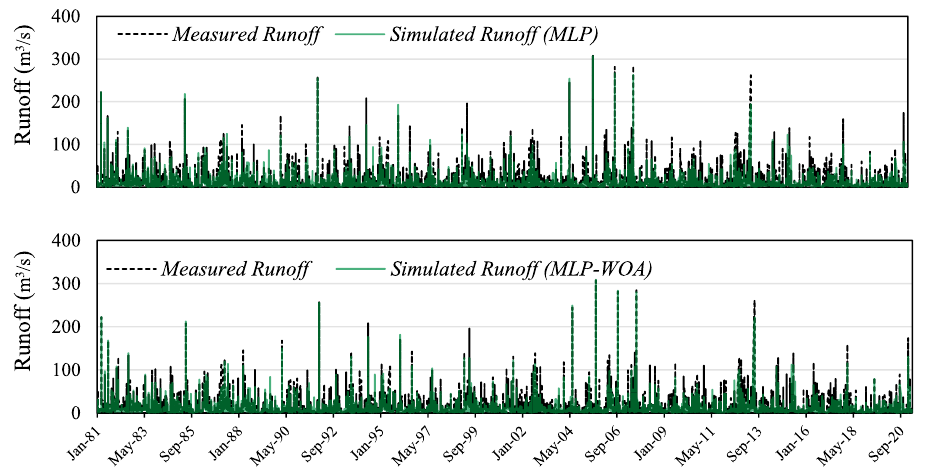
Figure 10. Time series plot related to the result of MLP and MLP-WOA models.